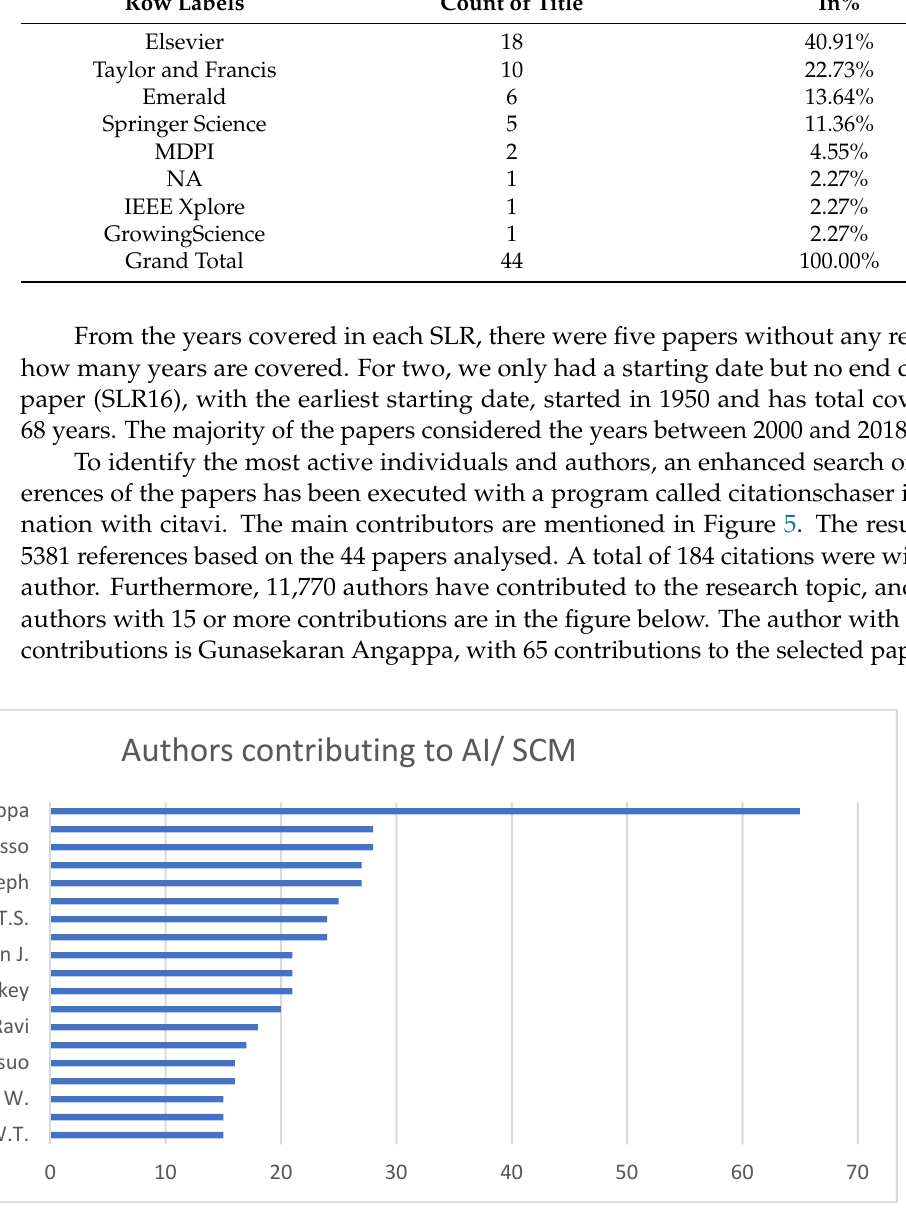
Figure 5. Authors contributing to AI/SCM research.